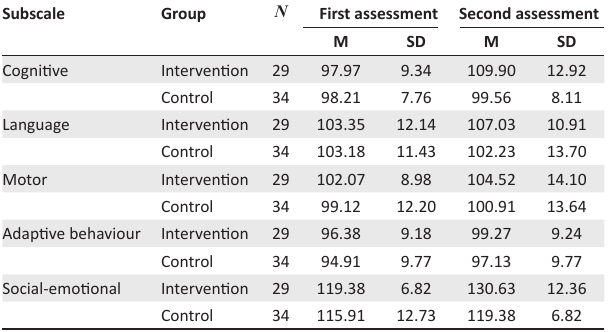
TABLE 1: Means and standard deviations of the composite scores for the intervention group and the control group for each subscale. Subscale Group